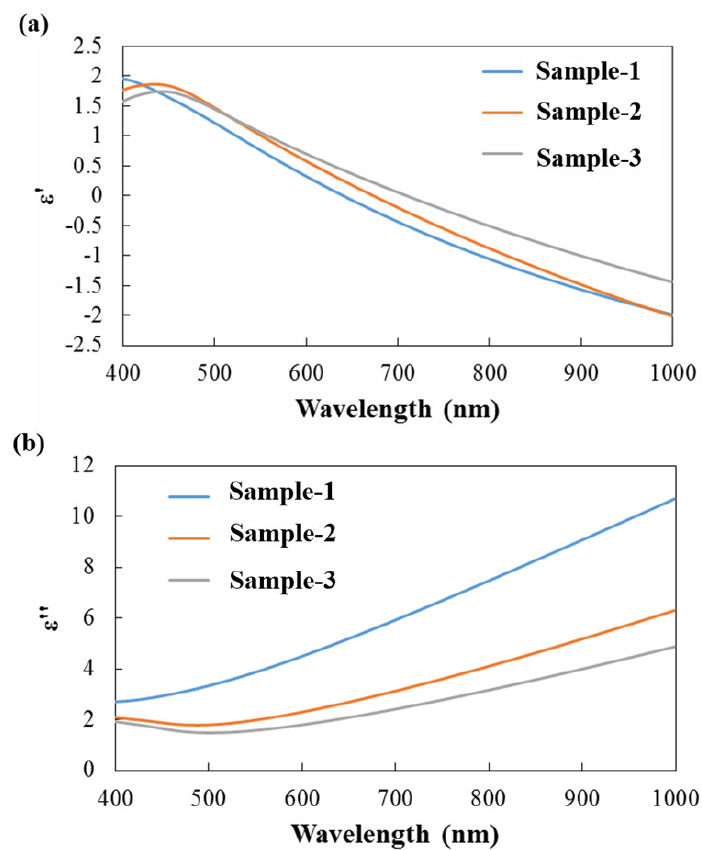
Figure 4. ( a ) The real and ( b ) imaginary part of permittivity for TiN thin films with R N2 = 1.5 sccm, R N2 = 3.5 sccm, and R N2 = 5 sccm.